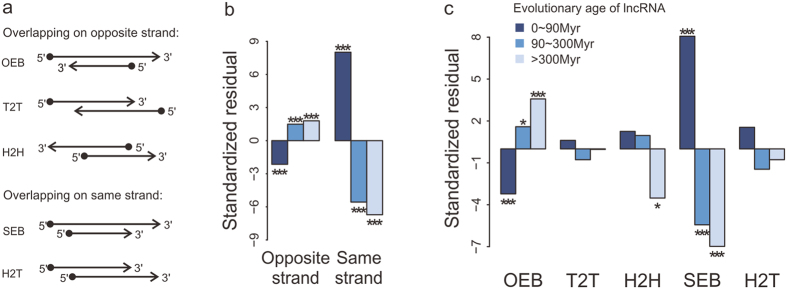
Overlapping configuration preference of human lncRNA-coding pairs.(a) Schematic representation of lncRNA-coding pairs, according to the orientation of the overlapping genes. Arrows indicate the orientation directions of genes. (b,c) The preference of lncRNA-coding pairs in overlapping strands (b) or overlapping configurations (c), according to the evolutionary age of human lncRNA genes. The standardized residuals were calculated in a 2 × 2 contingency table and the asterisks on the bar stand for the statistical significances of Chi square test: one for p < 2.5 × 10−3, two for p < 10−5 and three for p < 10−10.